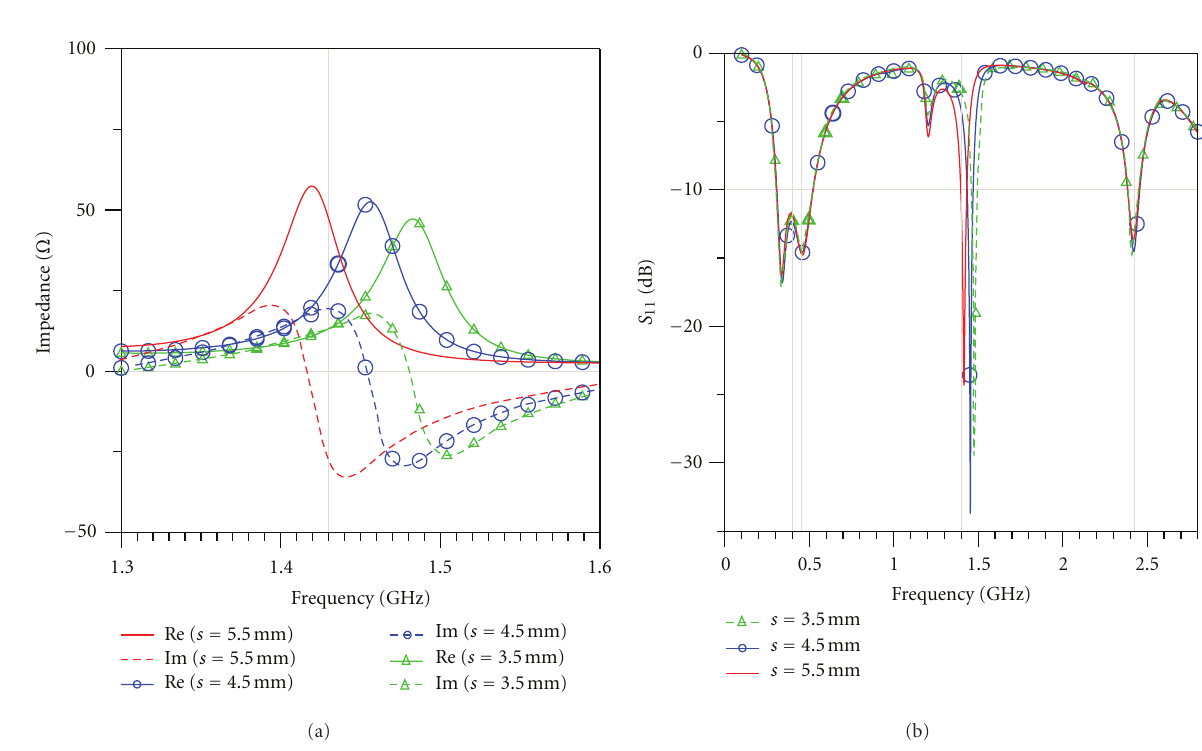
Figure 5: Simulated return loss for parameter of s in pork skin (a) impedance, (b) S 11 .